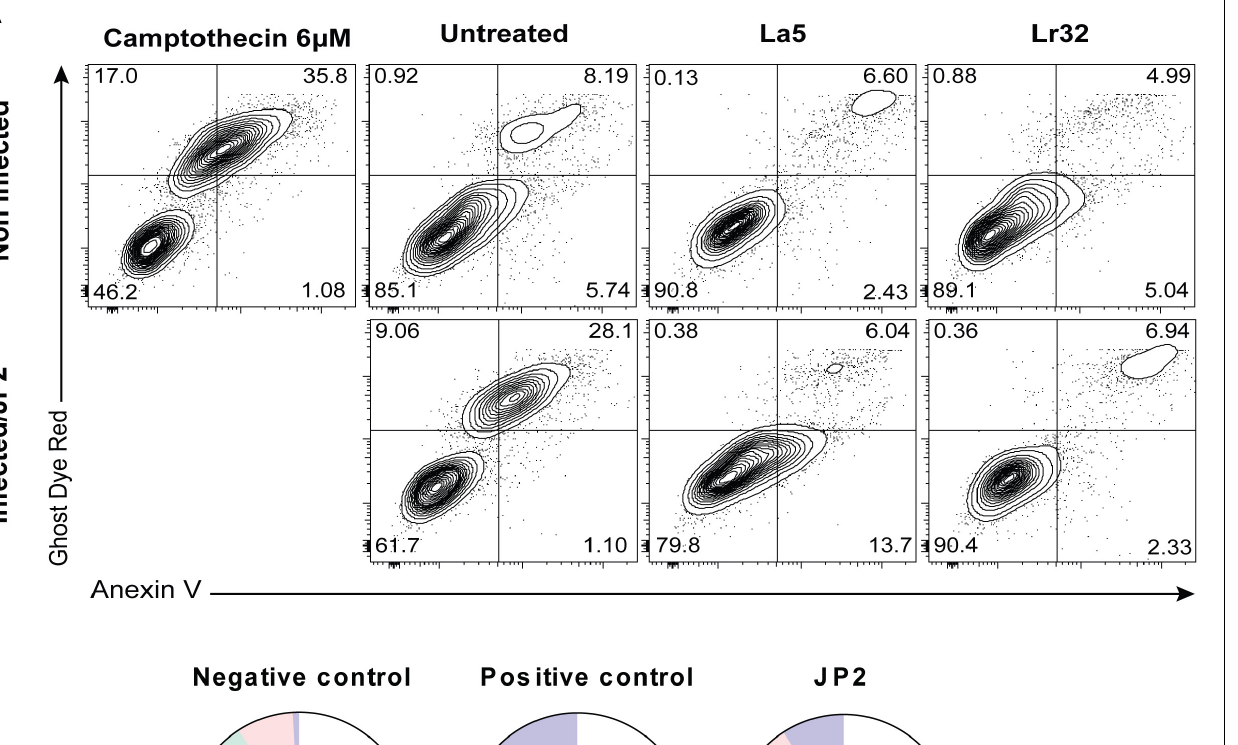
FIGURE 5 | Cytotoxicity by A. actinomycetemcomitans is mediated through apoptosis in gingival epithelial cells (GECs). (A) GECs were treated with A. actinomycetemcomitans at an MOI of 1:100 for 24 h and/or L. acidophilus La5 or L. rhamnosus Lr32 at an MOI 1:10. Camptothecin 6 uM was used as the positive control. The cells were stained with Annexin V and Ghost Dye Red and then analyzed using flow cytometry. Numbers indicate the percentage of cells in each panel. (B) Pie chart with the percentage of viable, early apoptosis, late apoptosis, and necrotic cells.